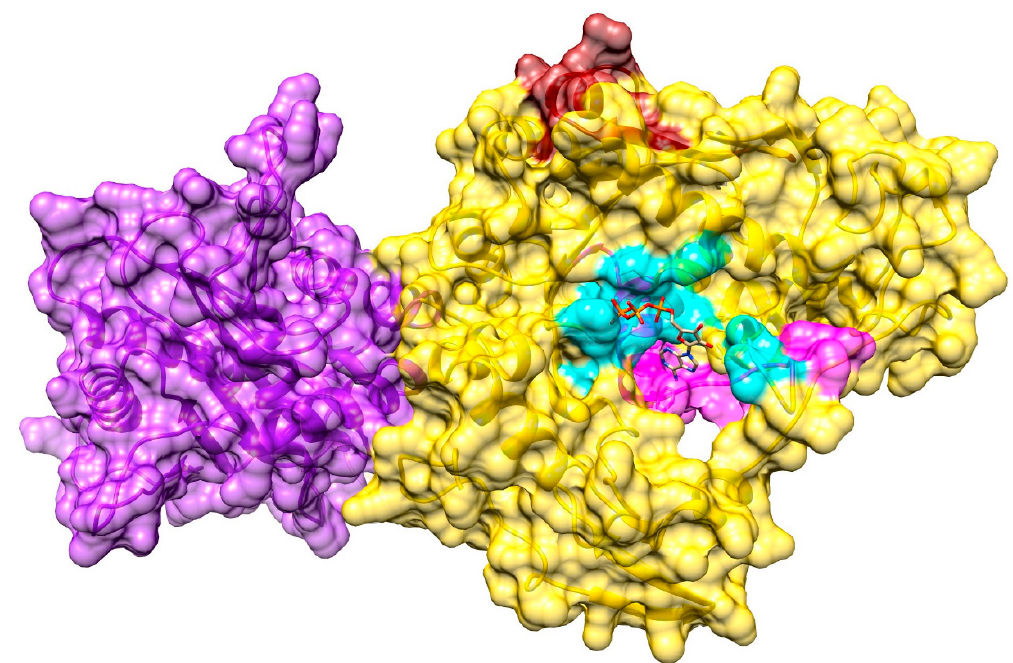
Figure 6. Model of pUL15 complexed with ATP. The N-terminal of the protein is yellow, and the C-terminal is purple. The predicted ATP-binding site is shown in cyan, whereas the two Walker boxes are colored in magenta (Walker box A) and brick red (Walker box B).